Question: Name the type of graph shown.
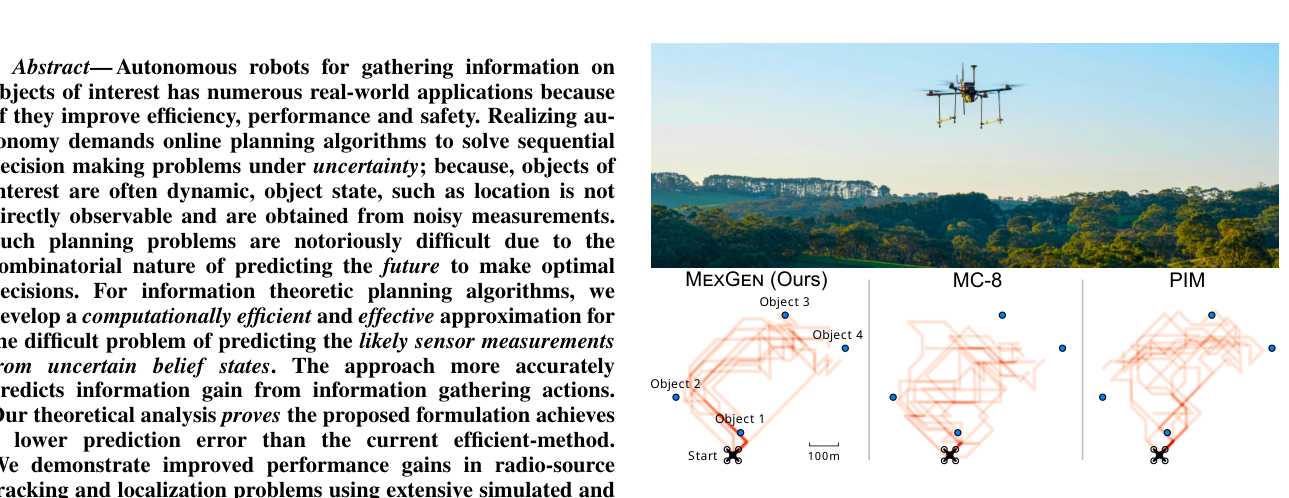
Answer: heatmap